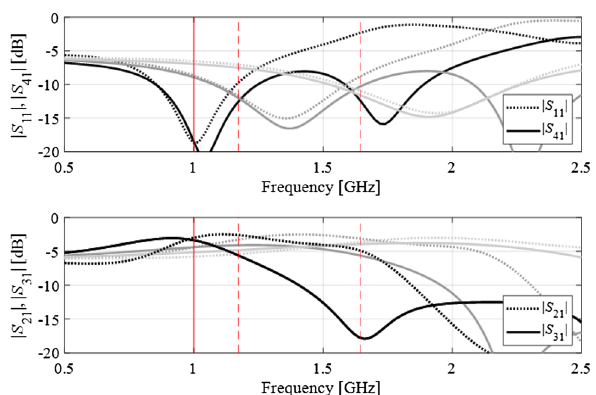
Figure 8. Branch-line coupler: scattering parameters at three intermediate designs, marked using the light-gray, dark-gray, and black colors (optimum), along with the corresponding target frequencies. For the sake of clarity, the matching/isolation characteristics are shown separate from the transmission